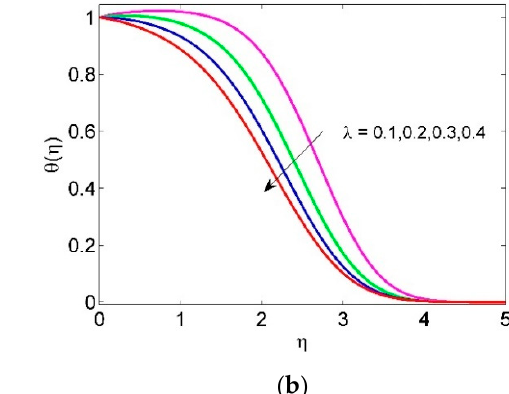
Figure 3. Impacts of λ on 𝑓 ′ (𝜂) and 𝜃(𝜂) . According to Figure 4a, the profile of velocity is enhanced with larger values of M because the magnetic property has a substantial effect on nanoparticles interaction with the electromagnetic field. Additionally, nanoparticles respond strongly to the magnetic field since they are in sync with the electromagnetic field. Since the magnetic field assists the fluid flow, it drives the nanoparticles toward the cylinder surface. This lively process reduces the temperature as well as the concentration field (see Figure 4b,c).